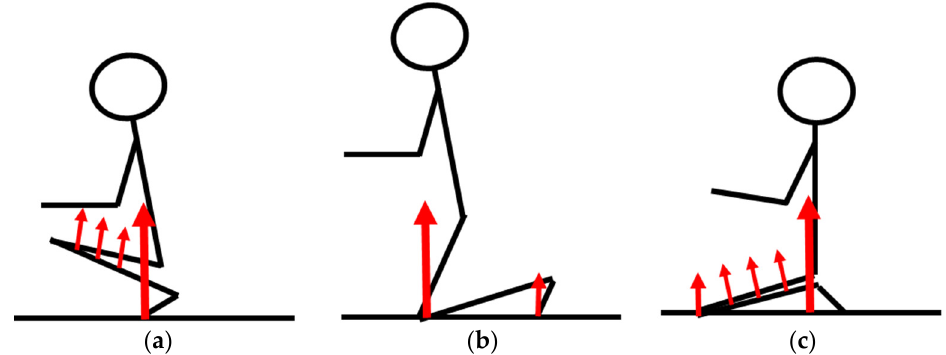
Figure 1. External forces to be considered in the analysis of ( a ) deep squatting, ( b ) upright kneeling, and ( c ) deep